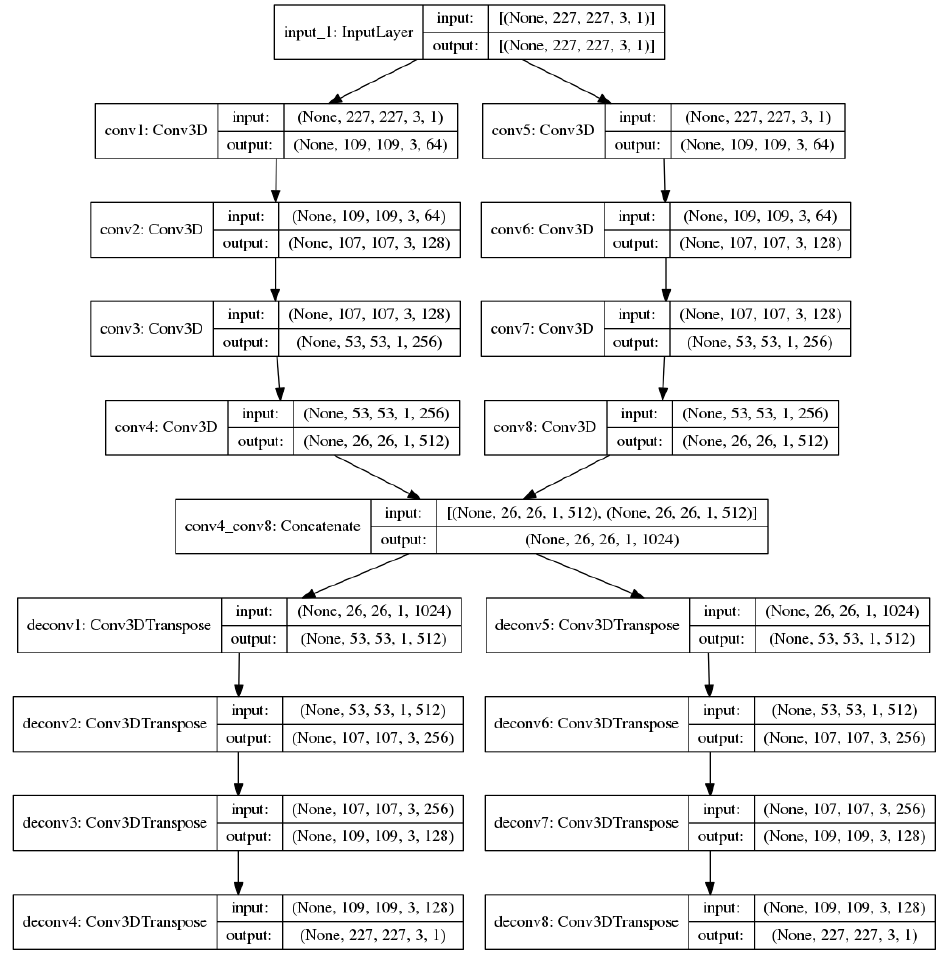
Figure 1. The proposed deep-learning